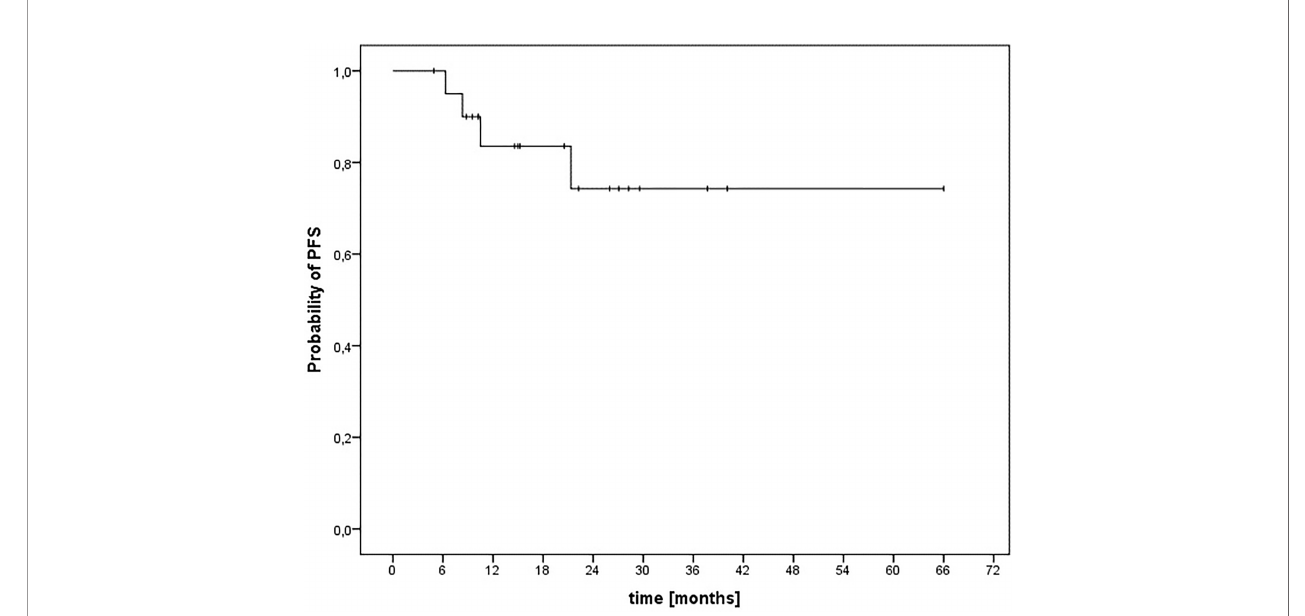
FIGURE 4 | Kaplan – Meier estimation of progression-free survival after CIRT-B combined with VMAT.